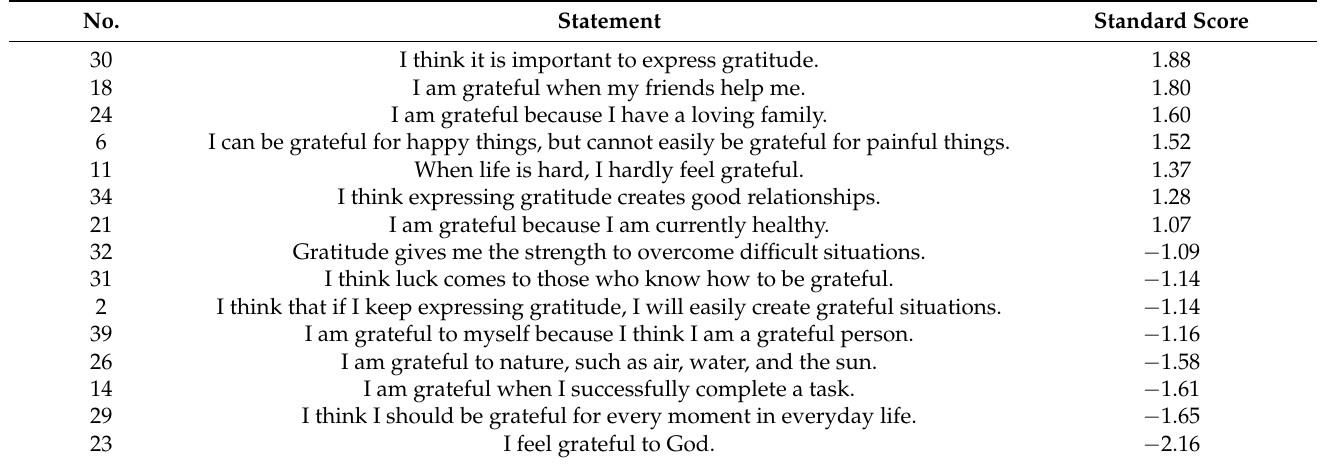
Table 8. Statements and standard scores (at least ± 1.00) of Type 2.